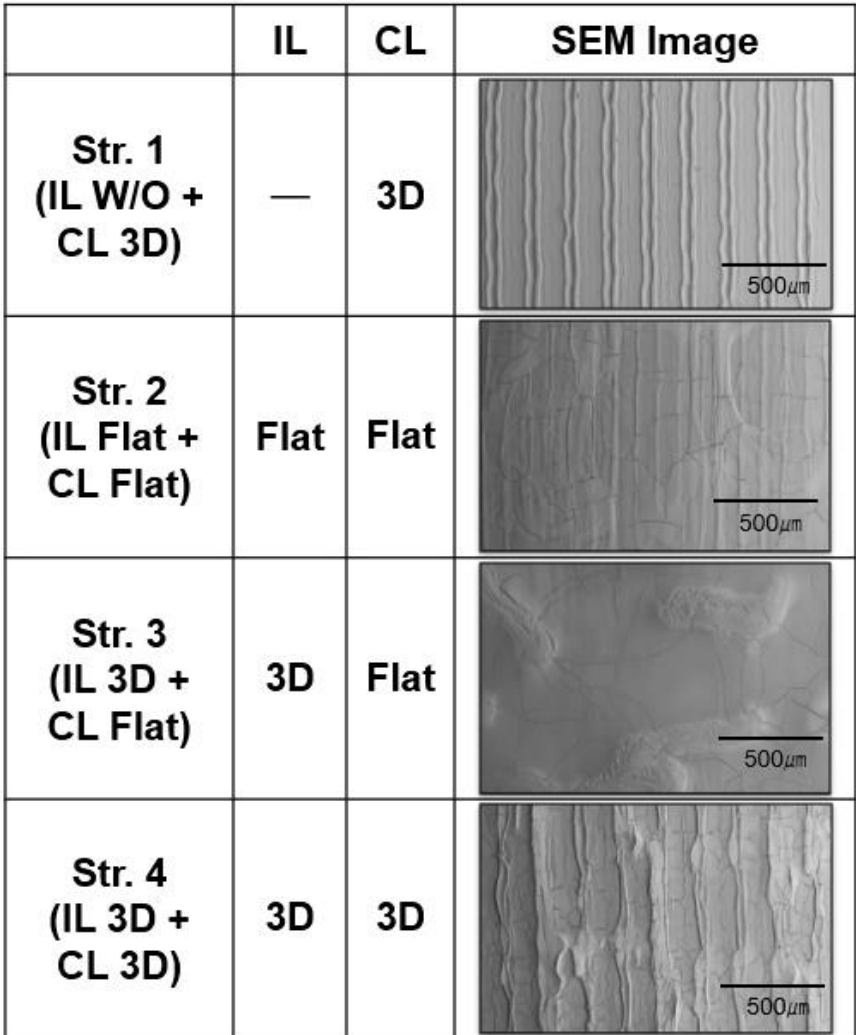
Figure 5. SEM images of the four types of 3D-patterned and flat-patterned structures fabricated using ionomer solution and catalyst ink.